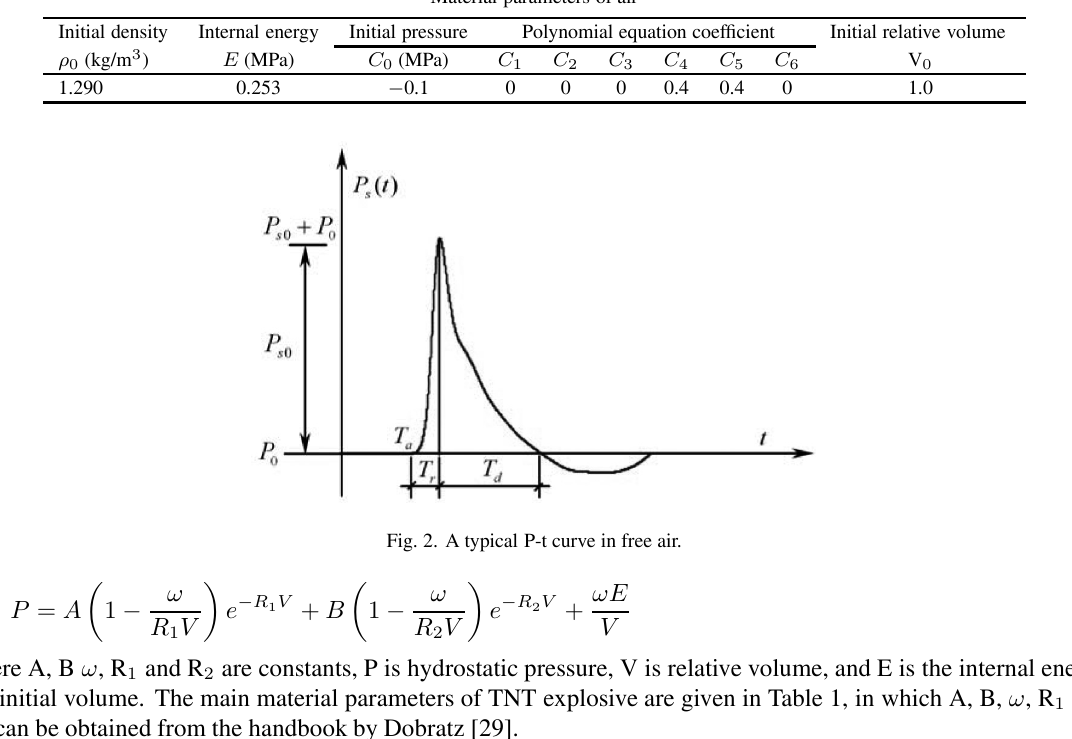
Fig. 2. A typical P-t curve in free